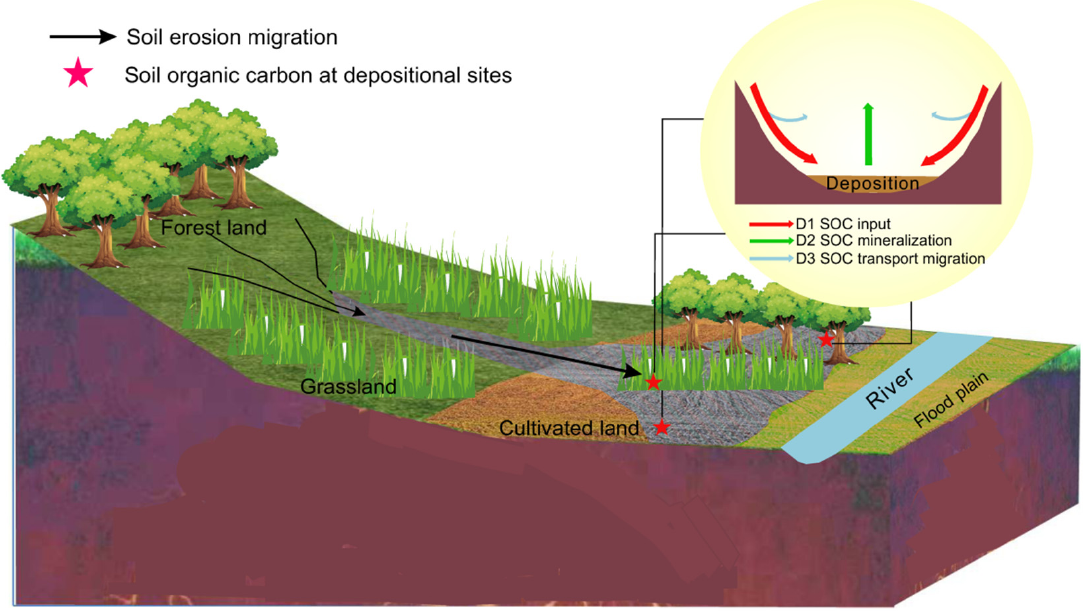
Figure 2. Carbon fluxes between erosive soil deposits of cropland, forestland, grassland and atmosphere in a red soil hilly region.